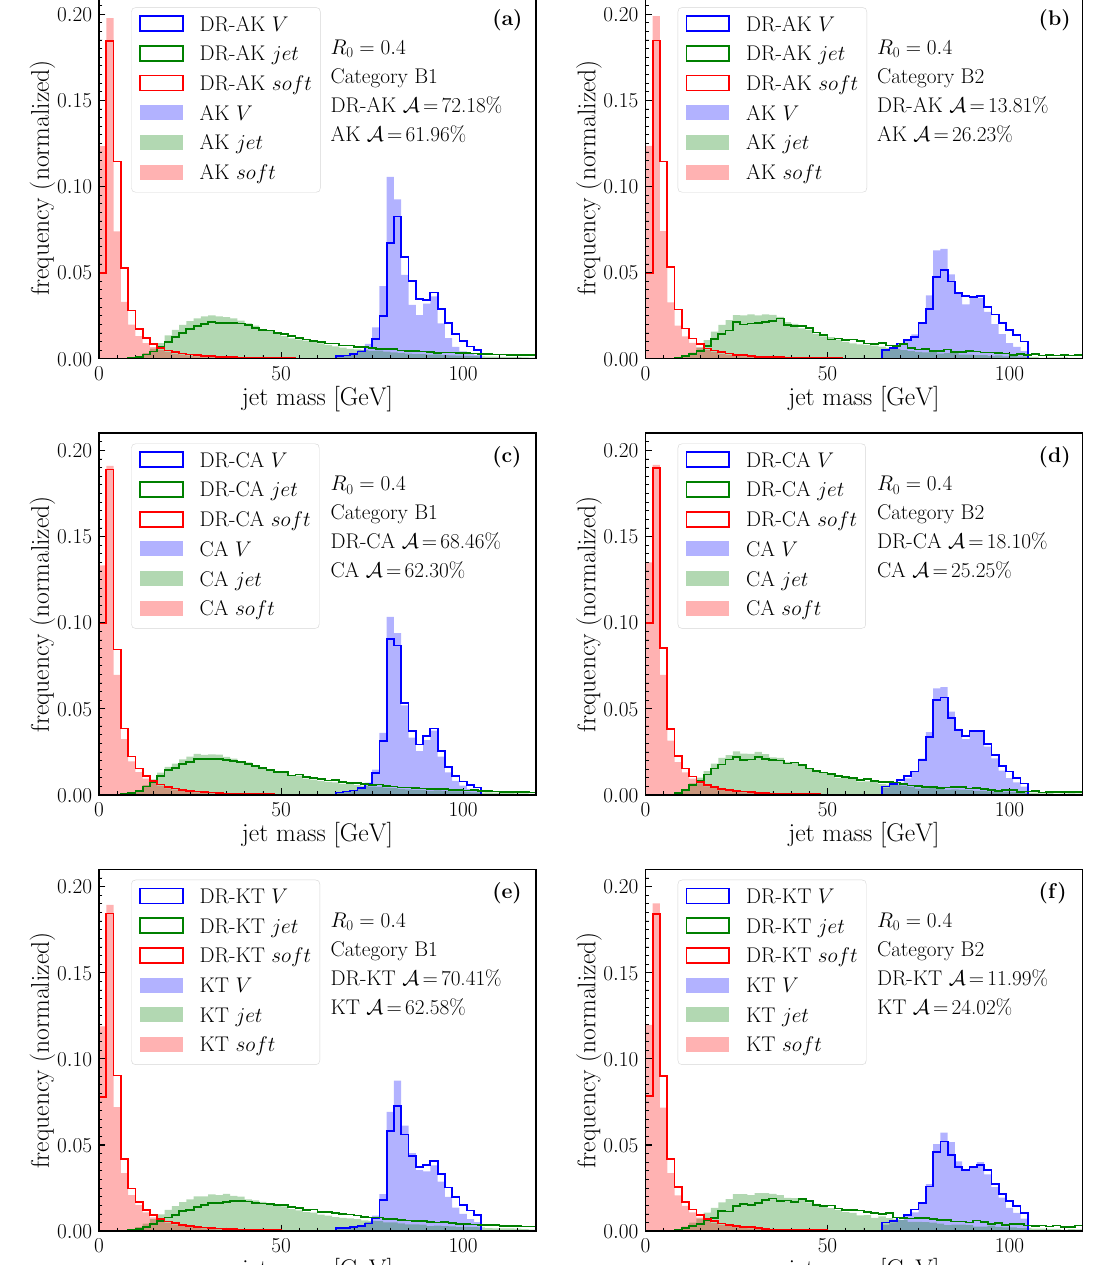
Figure 7 . Normalized distributions of jet mass for the process pp → V j . The left panel shows jet mass distributions of category B1 events and the right panel is the distribution for category B2 events. The blue, green, and red histograms are for reconstructed V , energetic jet and soft jets (defined in the text), respectively. The histograms, from top to bottom, are for AK, CA, and KT algorithms, respectively. The filled histograms correspond to fixed radius algorithms and the unfilled ones correspond to their dynamic radius (DR)